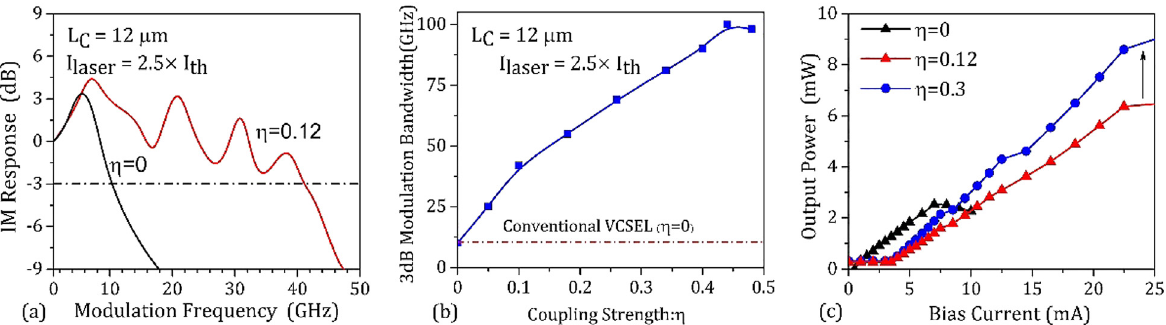
Figure 2: The design of hexagonal transverse-coupled-cavity vertical-cavity surface-emitting lasers (VCSEL). (a) Small-signal intensity modulation (IM) response for VCSEL with six identical feedback cavities with length and coupling strength of Lc =12µmand η =0.12,respectively.IMresponsewitharobustfeedbacksystem( η =0.12)provides3-dBroll-offmorethan42GHz(Equations (1)and(2)).ConventionalVCSELfabricatedonthesameepiwaferwith3-dBroll-off ∼ 9GHzisshownforcomparison( η =0),(b)Showsthe3-dB modulation bandwidth versus coupling strength ( η ). The 3-dB roll-off can exceed 100 GHz via further increasing the coupling strength to η =0.45.Note,theincreasedofthecouplingstrengthdirectlyaffectsthestabilityofthelaser,and(c)showsoutputpowerasafunctionofbias current of the inner cavity. The black line with a triangle symbol indicates the L – I curve of a conventional VCSEL with an aperture size of 3 × 3 µm 2 . The red and blue curves are for multiple transverse-coupled-cavity VCSEL (MTCC VCSEL) with six identical feedback cavities